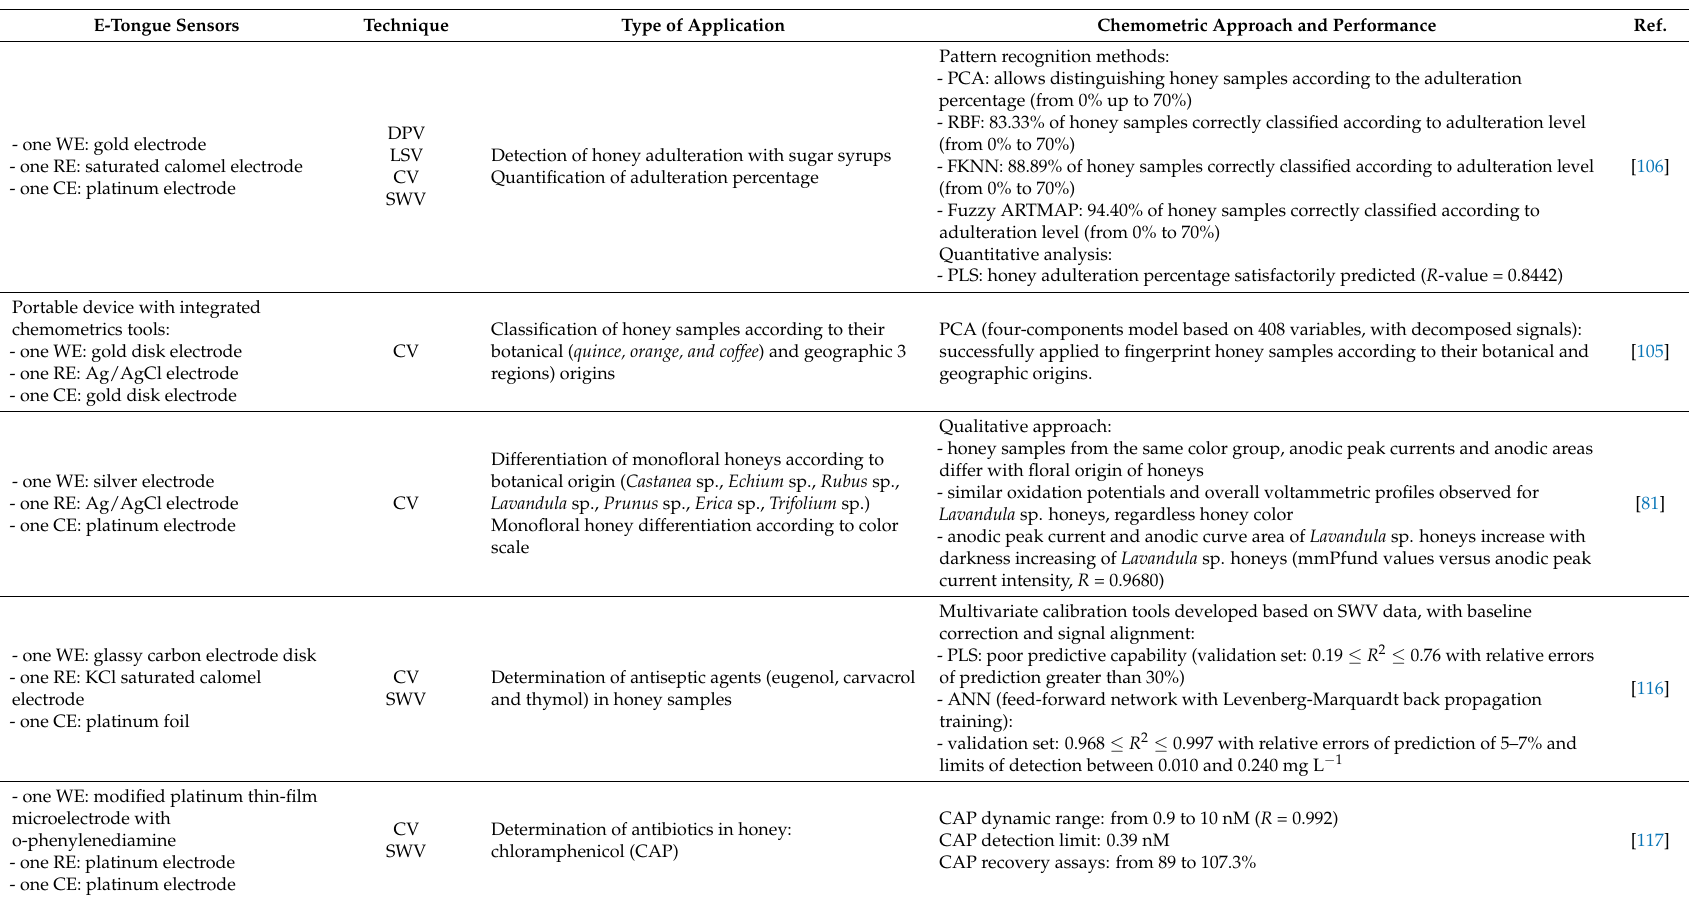
Technique Type of Application Chemometric Approach and